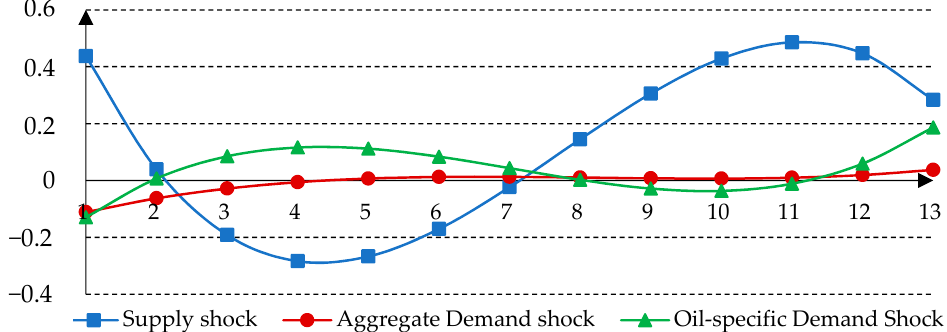
Figure 6. Changes in parameters of VIX index in response to structural shock.